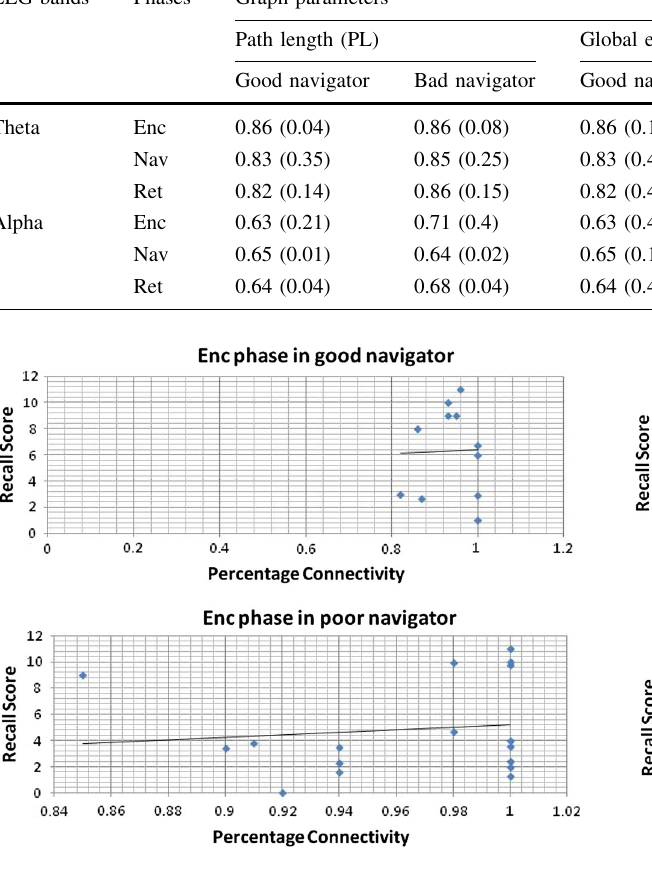
Fig. 5 Scatter plot between recall score and small world index (SWi) during Navigation phase in good navigator ( R 2 = 1%), and poor navigator ( R 2 =